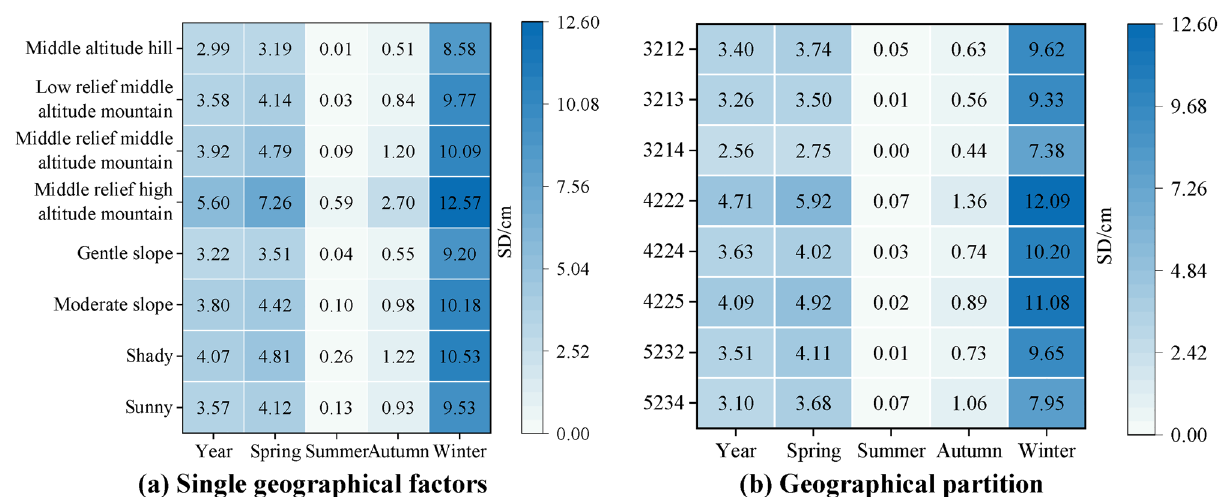
Figure 12. Geographical factors average snow depth year and